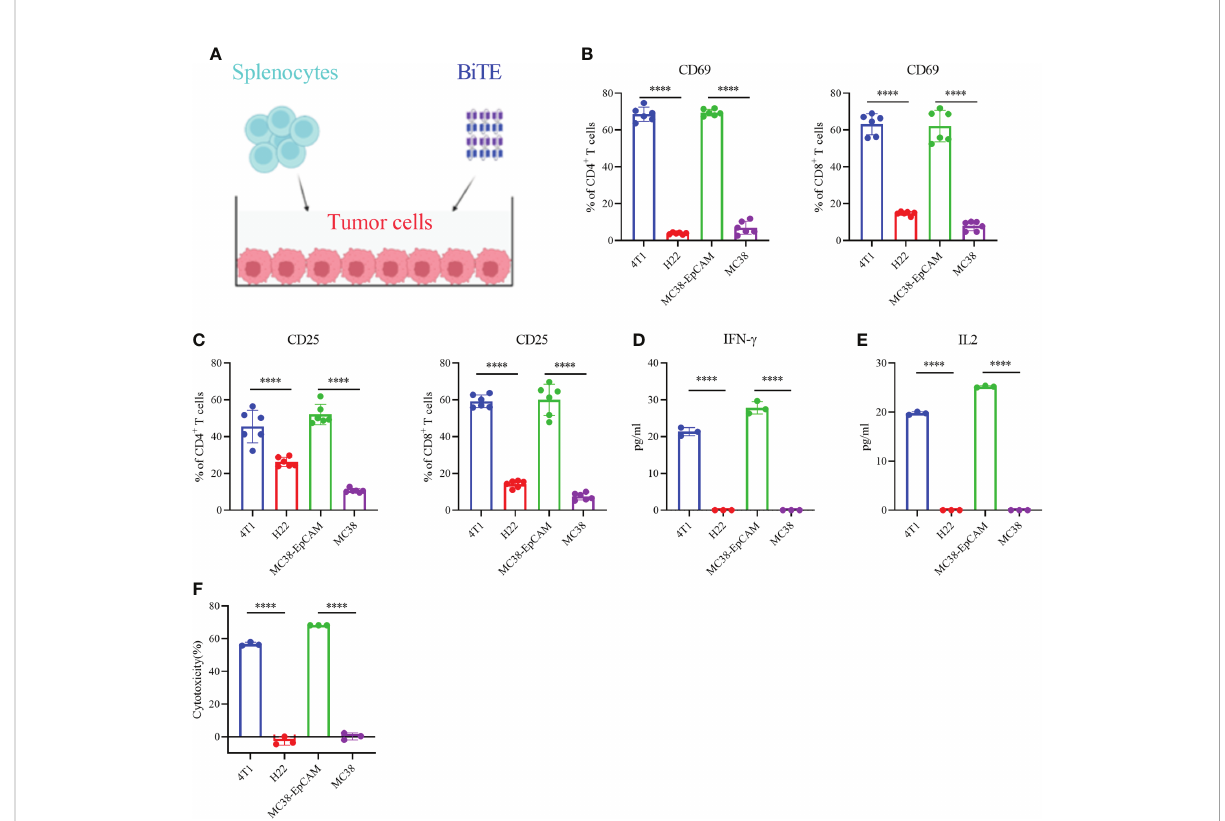
FIGURE 2 Secreted EpCAM BiTE induces naive T-cell activation and cytotoxicity of tumor cells. (A) Schematic diagram of the T-cell toxicity test. (B, C) Expression of CD69 and CD25 on the surface of CD4 + and CD8 + T cells. 4T1, H22, MC38-EpCAM and MC38 cells were cocultured with splenocytes at an effector to target (E:T) ratio of 10:1 in the presence of EpCAM BiTE. Cells were harvested at 48 hours and then assayed by fl ow cytometry. (D, E) BiTE-induced cytokine secretion. The secretion levels of IFN- g and IL-2 were determined by enzyme-linked immunosorbent assay (ELISA). (F) T-cell cytotoxicity. 4T1, H22, MC38-EpCAM and MC38 cells were cocultured with murine splenocytes and EpCAM BiTE for 48 h for the luciferase assay, and the tumor cell lysis rate was calculated. ****p <